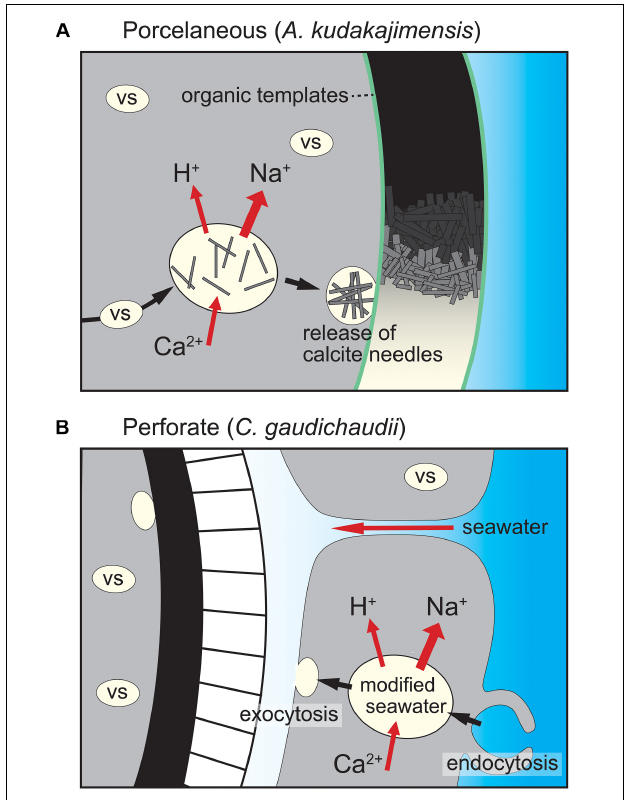
FIGURE 2 | Simplified schemes describing the possible cation transport processes in (A) porcelaneous and (B) perforate foraminifera modified after Erez (2003) and de Nooijer et al. (2009). vs, vacuolized seawater.